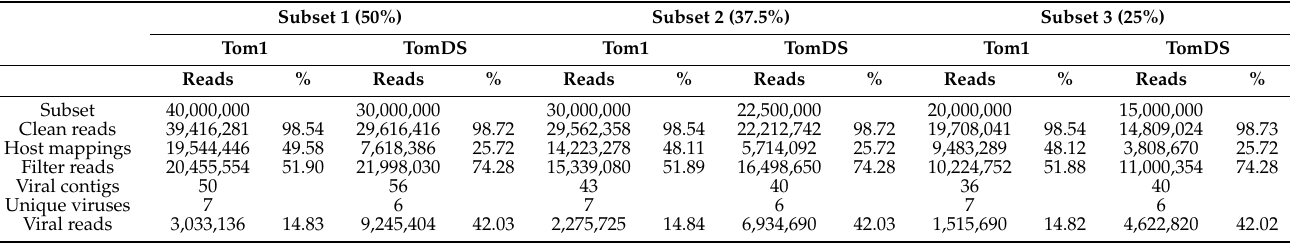
Table 4. Summary of results obtained after subsetting the raw